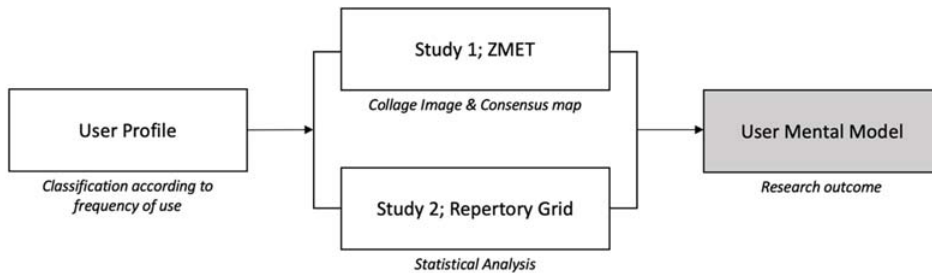
Figure 1. Research Method and Structure.